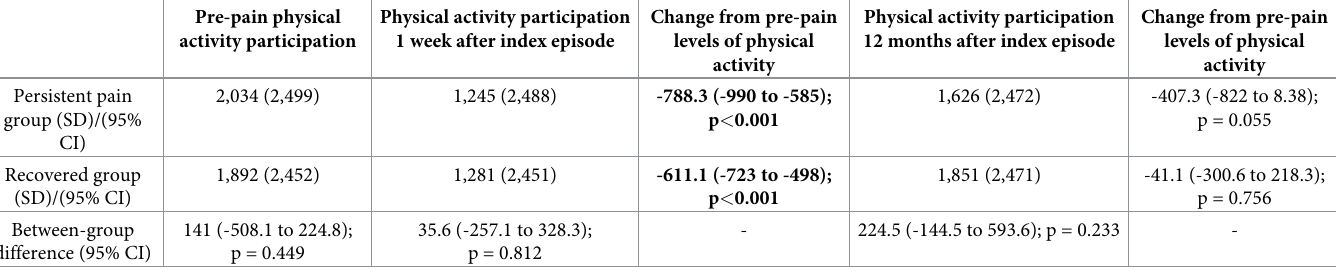
Table 2. Difference in physical activity level (total MET minutes per week) before the onset of low back pain within group among multiple time-points. Pre-pain physical Physical activity participation Change from pre-pain Physical activity participation activity participation 1 week after index episode levels of physical 12 months after index episode activity